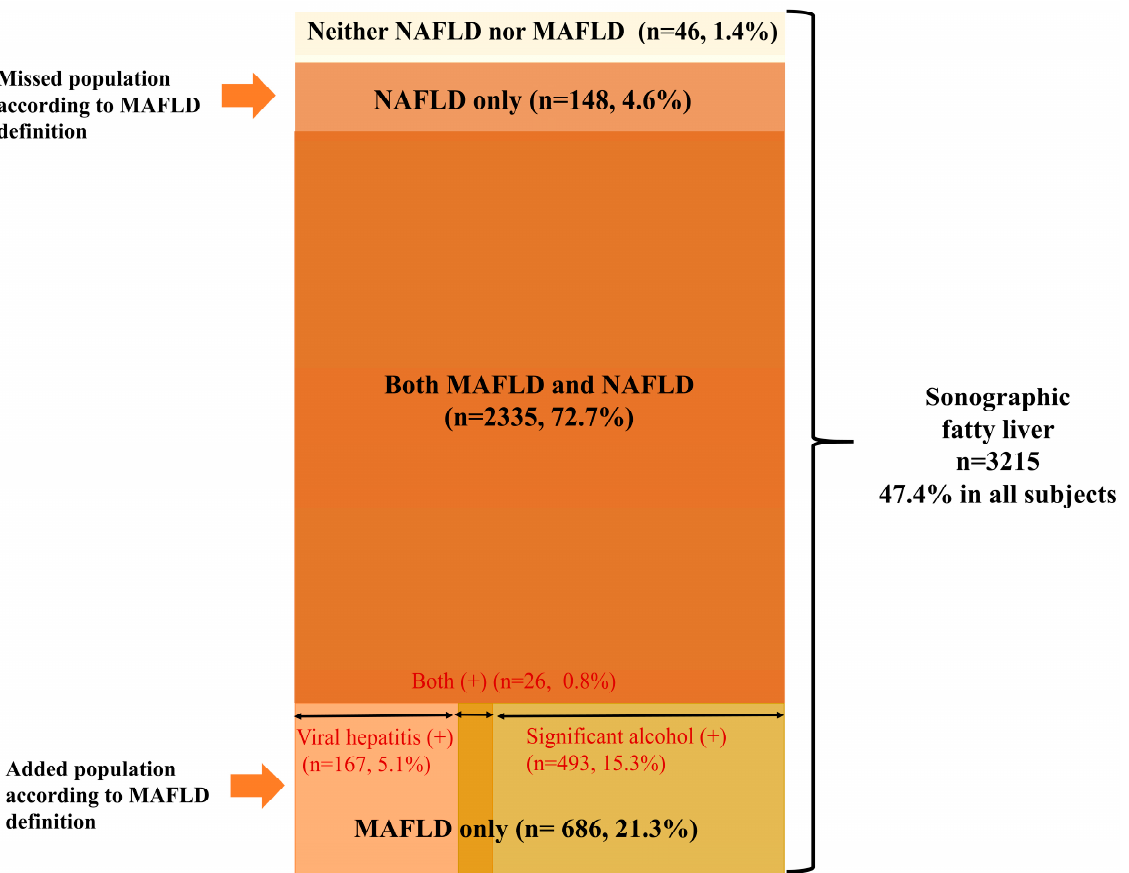
Figure 2. Venn diagram representing the prevalence of fatty liver disease in the community-based cohort, according to the definition of NAFLD and MAFLD. Abbreviations: MAFLD, metabolic-associated fatty liver disease; NAFLD, non-alcoholic fatty liver disease.